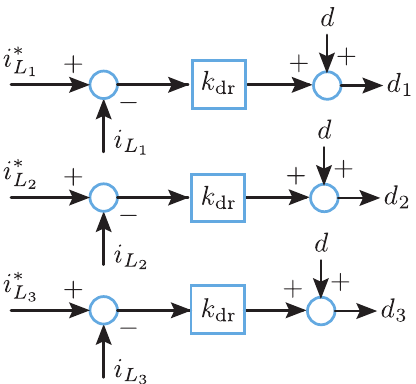
Figure 11. Droop correction to equalize and control output currents of all converters.